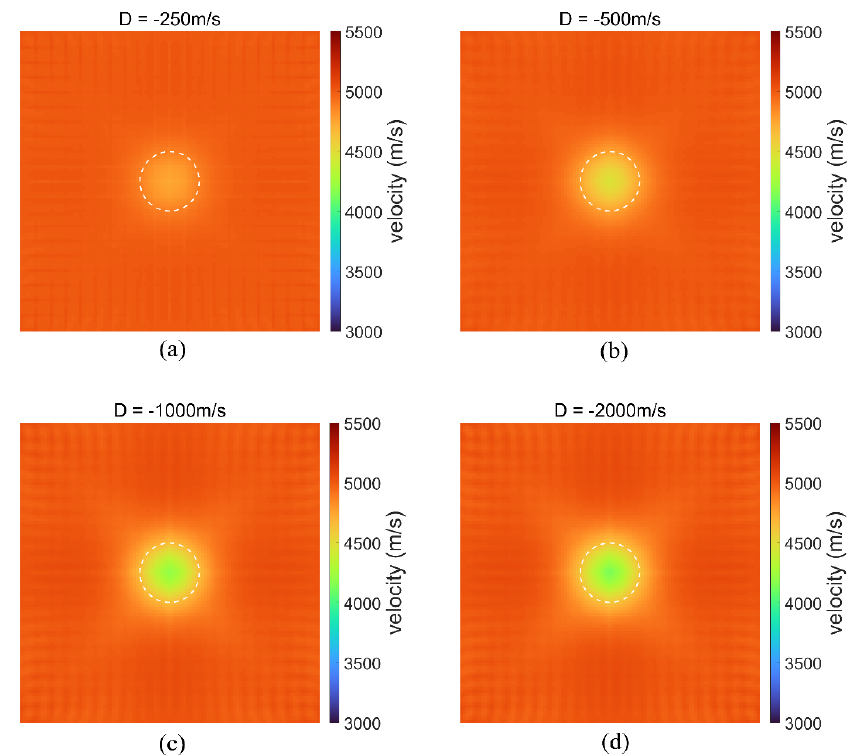
Figure 6. Tomographic results obtained by TDAT with different low − velocity anomalies. D: velocity difference between background and anomalous area.